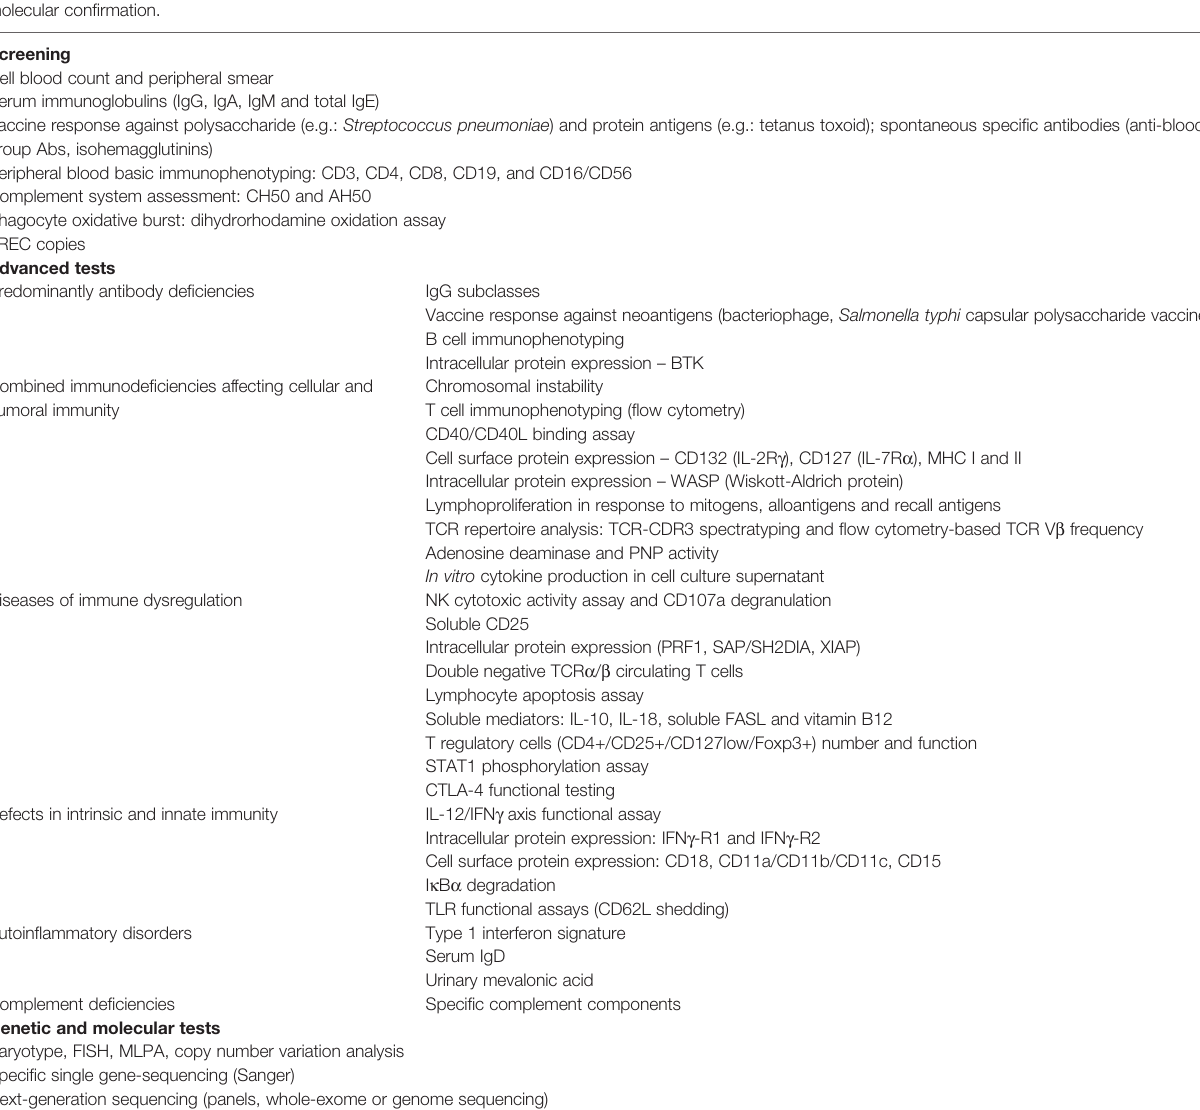
TABLE 2 | Suggested IEI clinically guided laboratory investigation guidelines, according to three proposed main consecutive steps: screening, advanced tests, and molecular con fi rmation. Screening Cell blood count and peripheral smear Serum immunoglobulins (IgG, IgA, IgM and total IgE) Vaccine response against polysaccharide (e.g.: Streptococcus pneumoniae ) and protein antigens (e.g.: tetanus toxoid); spontaneous speci fi c antibodies (anti-blood group Abs, isohemagglutinins) Peripheral blood basic immunophenotyping: CD3, CD4, CD8, CD19, and CD16/CD56 Complement system assessment: CH50 and AH50 Phagocyte oxidative burst: dihydrorhodamine oxidation